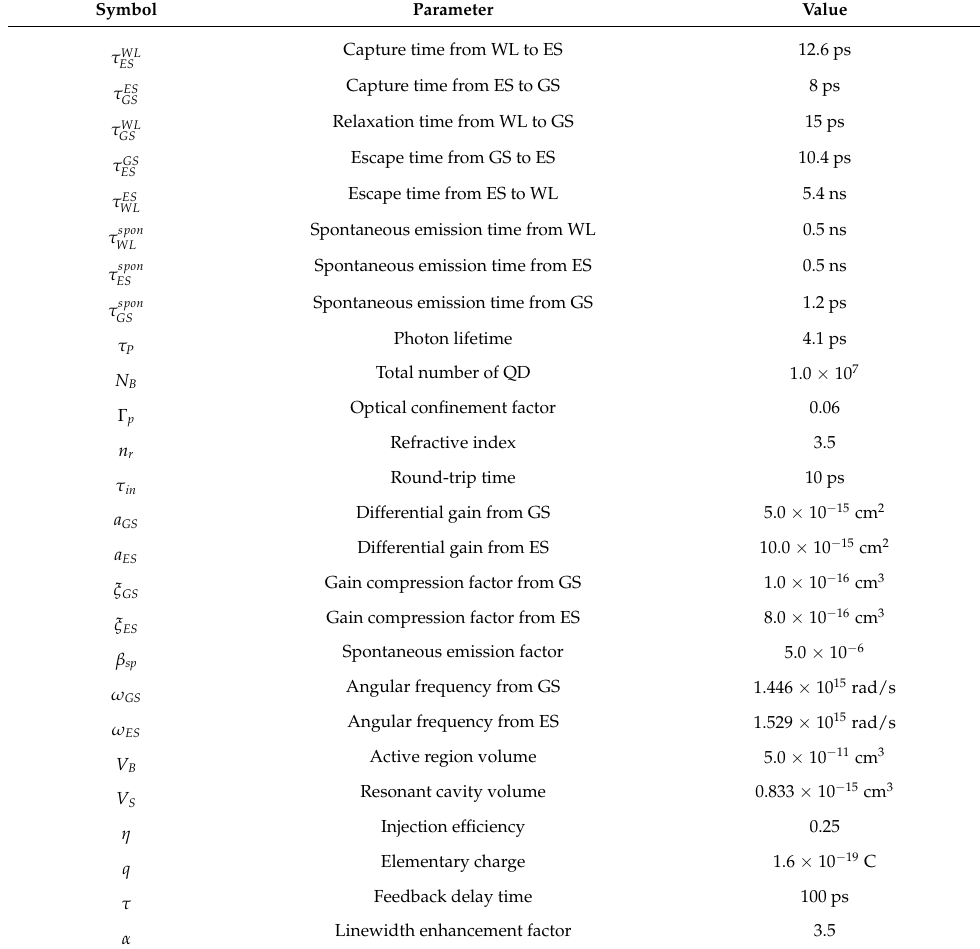
Figure 1. Schematic diagram of the carrier dynamics for QD lasers based on the three-level model. WL: wetting layer; GS: ground state; ES: excited state. WL: wetting layer; GS: ground state; ES: excited state. Table 1. Simulation parameters of the QD